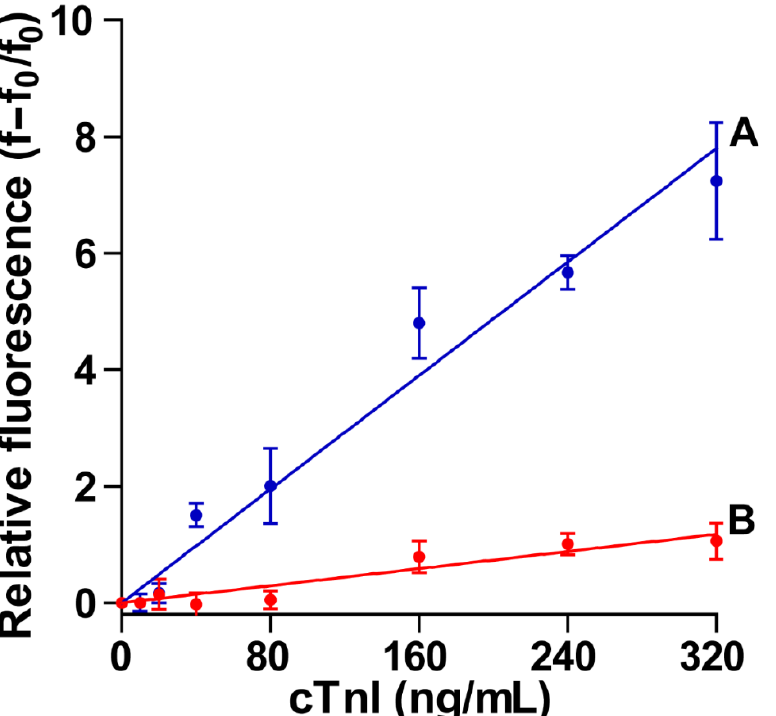
Figure 3. Standardization of assay incubation time. Assay trials were done by varying the incubation time for each step addition; (A) cTnI and Ab 2 –biotin for 60 min and other components (SA and calcein liposome) for 30 min; (B) cTnI and Ab 2 –biotin were incubated for 30 min and other parameters (SA, blocking liposome, and calcein liposome) for 15 min. Less response was observed for B compared to A. Assay conditions used were as follows: coating antibody concentration of 5 µ g/mL, cTnI levels of 0–320 ng/mL, 2 µ g/mL of SA, 2 µ g/mL of Biotin–Ab 2 , and 1:100 diluted biotin calcein liposomes. The error bars show the standard deviation of values for the triplicate readings obtained for three different assay experiments. (Two-way ANOVA test showed that there is statistically significant difference ( p < 0.05) between A and B assays ( p < 0.001) and that the change in the relative fluorescence for each assay is significantly dependent (for A, p < 0.001; for B, p < 0.001) on the concentration of cTnI in